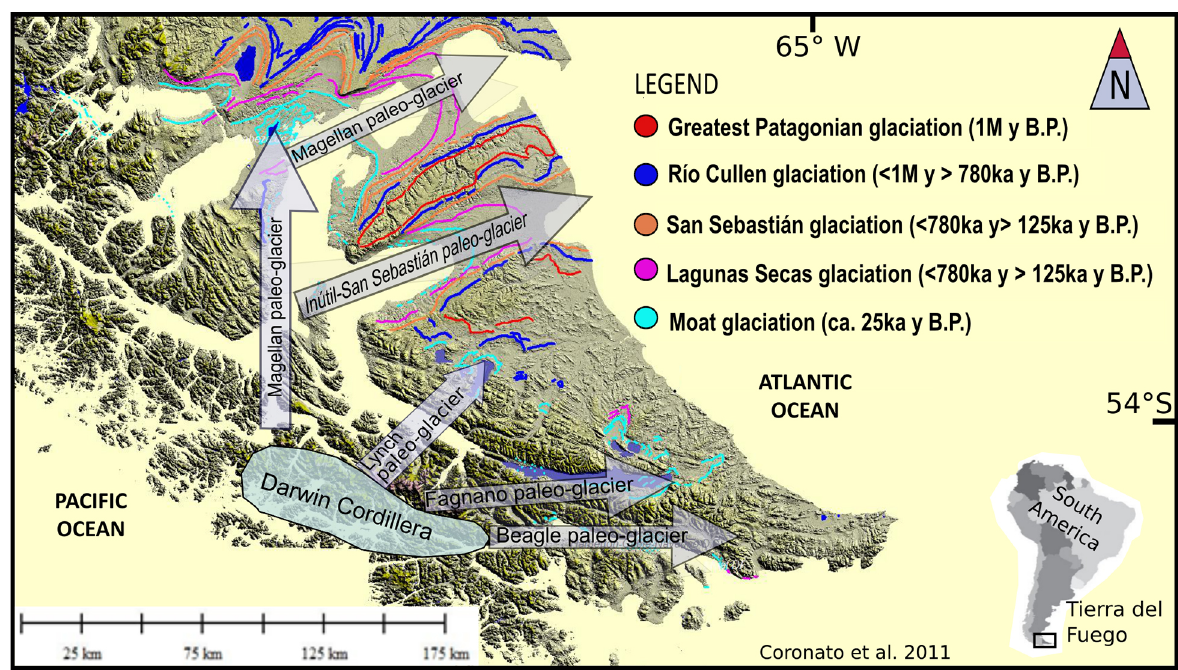
Fig. 2. The main glacial axis dispersed from the Darwin Cordillera ice-mountain sheet flowing in Tierra del Fuego and glacial limits along the main glacial valleys (modified from Coronato and Rabassa 2011). The map is based on Shuttle Radar Terrain Model (90 m